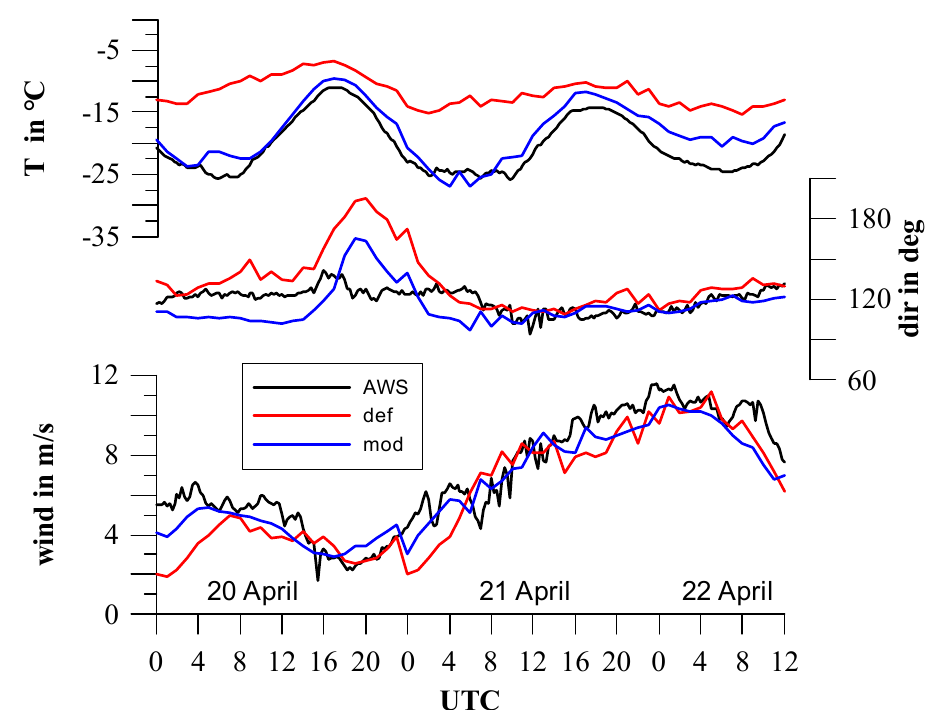
Figure 7. Temperature ( upper panel ), wind direction ( middle panel ) and wind speed ( lower panel ) for the period 00:00 UTC 20 April 1997 to 12:00 UTC 22 April 1997 for AWS A4 (15 min values, black), the standard turbulence parameterization (def, red), and the modified turbulence parameterization (mod, blue).